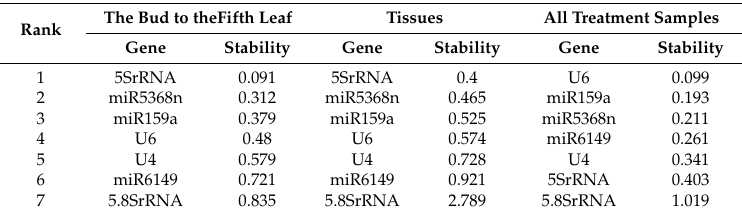
Figure 2. geNorm analysis of average expression stability values (M) and ranking of seven candidate reference genes. Average expression stability values (M) of candidate genes were measured during stepwise exclusion of the least stable reference genes. A lower value of average expression stability, M, indicates more stable expression. ( a ) Pooled samples from all treatments; ( b ) Pooled tissues; ( c ) In the bud to the fifth leaf. Table 2. Ranking of candidate reference genes in order of normalization and their expression stability calculated using NormFinder. The Bud to theFifth Leaf